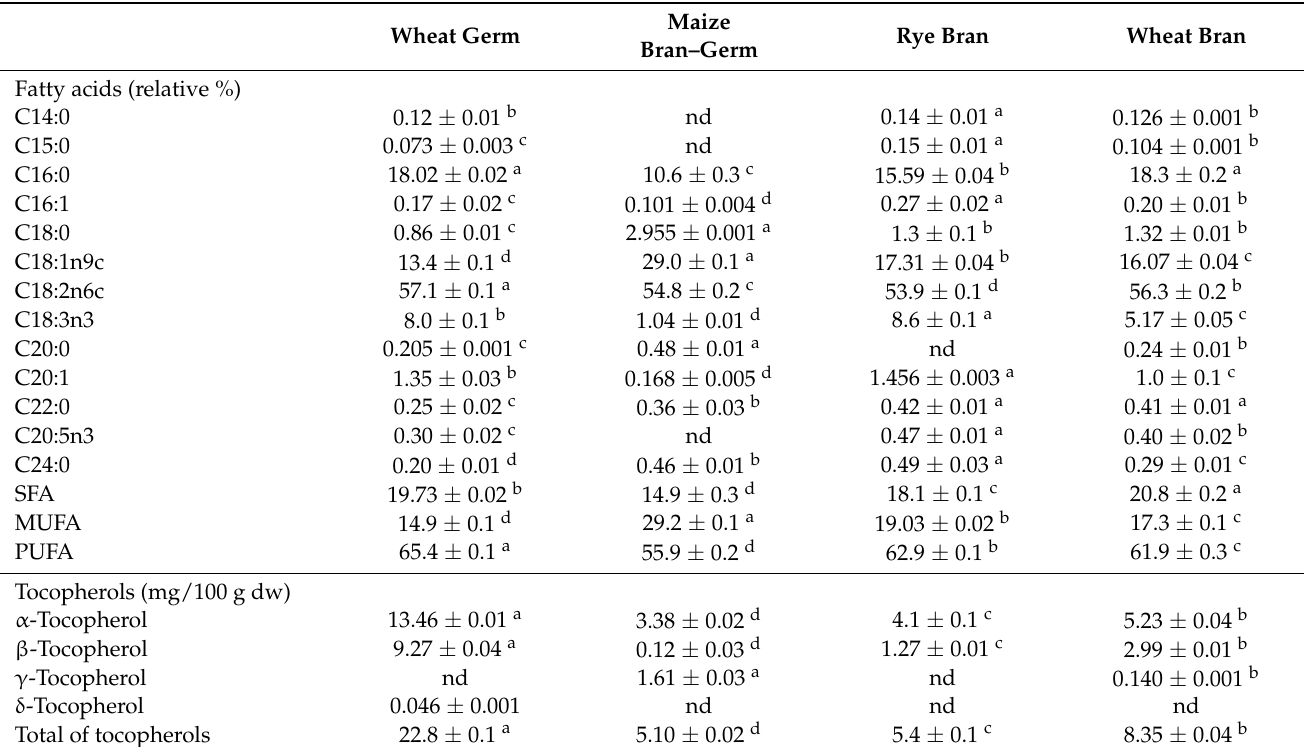
Table 3. Composition in fatty acids and tocopherols of the cereal by-products. Wheat Germ